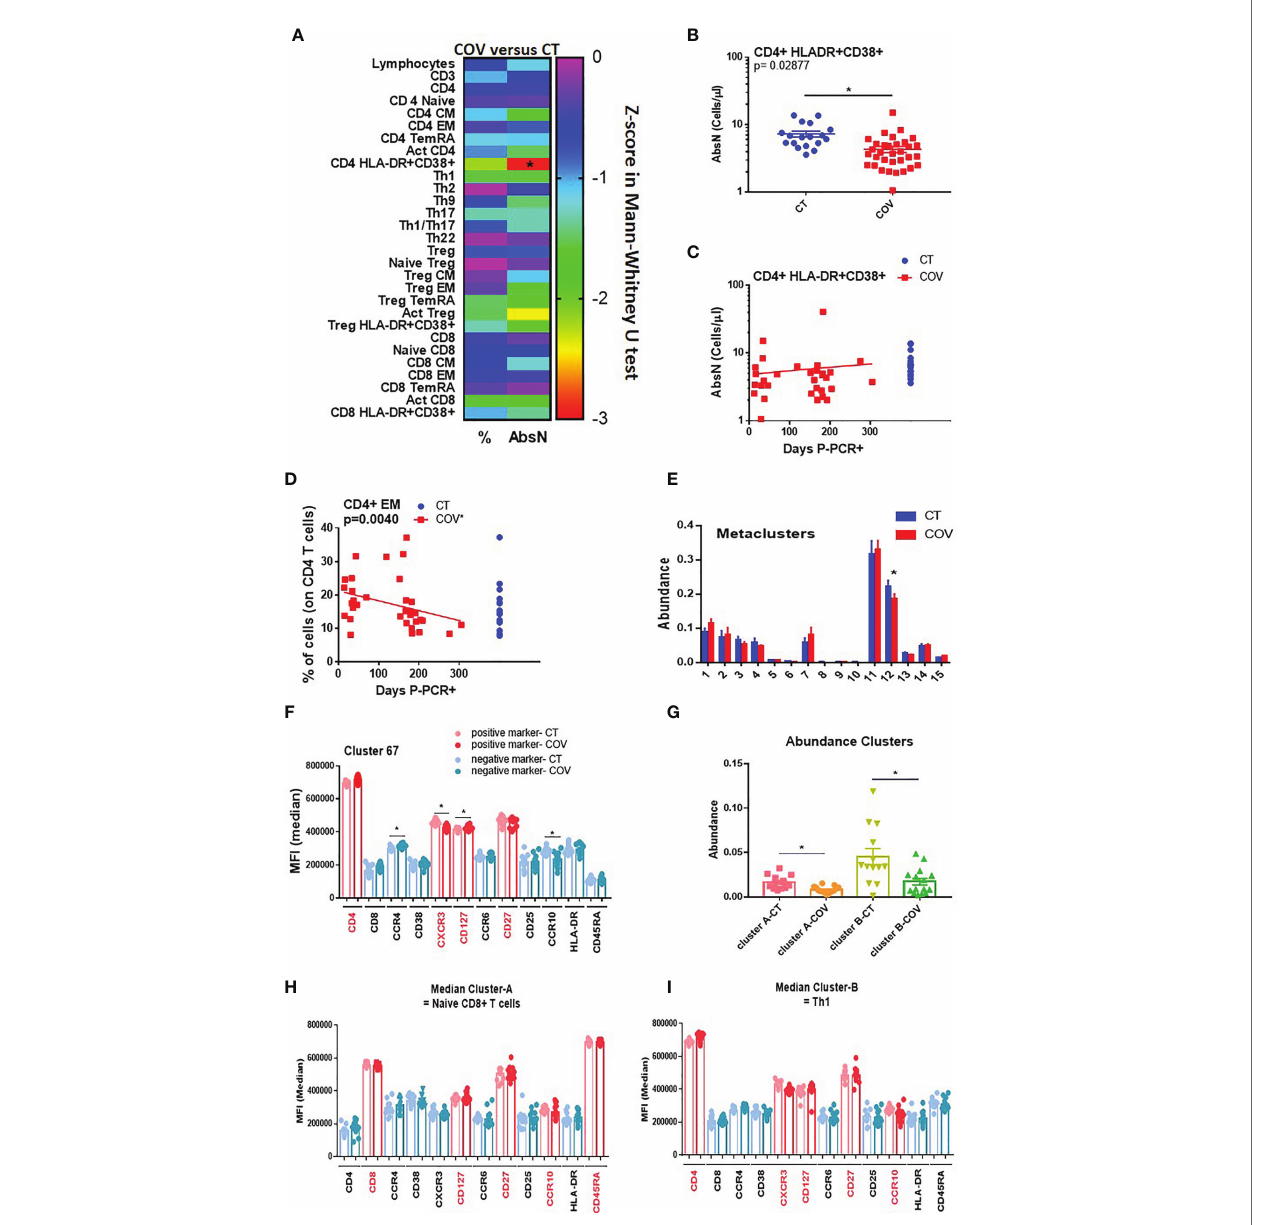
FIGURE 2 | Manual gating and high-dimensional fl ow cytometry unsupervised analysis in T-cell panel. (A) Heat map of the pairwise comparison between recovered COVID-19 (COV) and healthy control (CT) individuals of results obtained by classical manual fl ow cytometry gating. Statistical analysis was performed with the Mann – Whitney U test. The colour scale represents the Z-score on the right Y-axis. Immune population names are represented on the left Y-axis. The left column represents the z-score from the pairwise comparison for the cellular population ’ s percentage (%), and the right column represents the z-score from the pairwise comparison for the absolute numbers (cells/uL, AbsN). The p -value was corrected using the Benjamini – Hochberg method for multiple testing. (B) AbsN of CD4+ HLA-DR+ CD38+ in CT and COV individuals. Pairwise comparisons were performed using a Mann – Whitney U-test corrected using the Benjamini – Hochberg method for multiple testing; mean ± SEM. (C) Correlation between days P-PCR+ and CD4+ HLA-DR+ CD38+ AbsN. Spearman ’ s rank-order correlation test with Benjamini – Hochberg adjustment for multiple testing. (D) Correlation between days P-PCR+ and frequency of CD4+ effector memory (EM). Spearman ’ s rank-order correlation test with Benjamini – Hochberg adjustment for multiple testing. (E) The metaclusters ’ abundance was obtained through FlowSOM analysis. Two-way ANOVA with Benjamini – Hochberg adjustment for multiple testing. Median ± SEM. (F) The median of fl uorescence (MFI) of cluster 67 was obtained through a FlowSOM analysis. One-way ANOVA with Benjamini – Hochberg adjustment for multiple testing. Median ± SEM. (G) The clusters ’ abundance was signi fi cantly different between COV and CT individuals obtained through CITRUS analysis. One-way ANOVA with Benjamini – Hochberg adjustment for multiple testing. Median ± SEM. (H) The median of fl uorescence (MFI) of cluster A or cluster B (I) was obtained through CITRUS analysis. One-way ANOVA with Benjamini – Hochberg adjustment for multiple testing. Median ± SEM. * p <